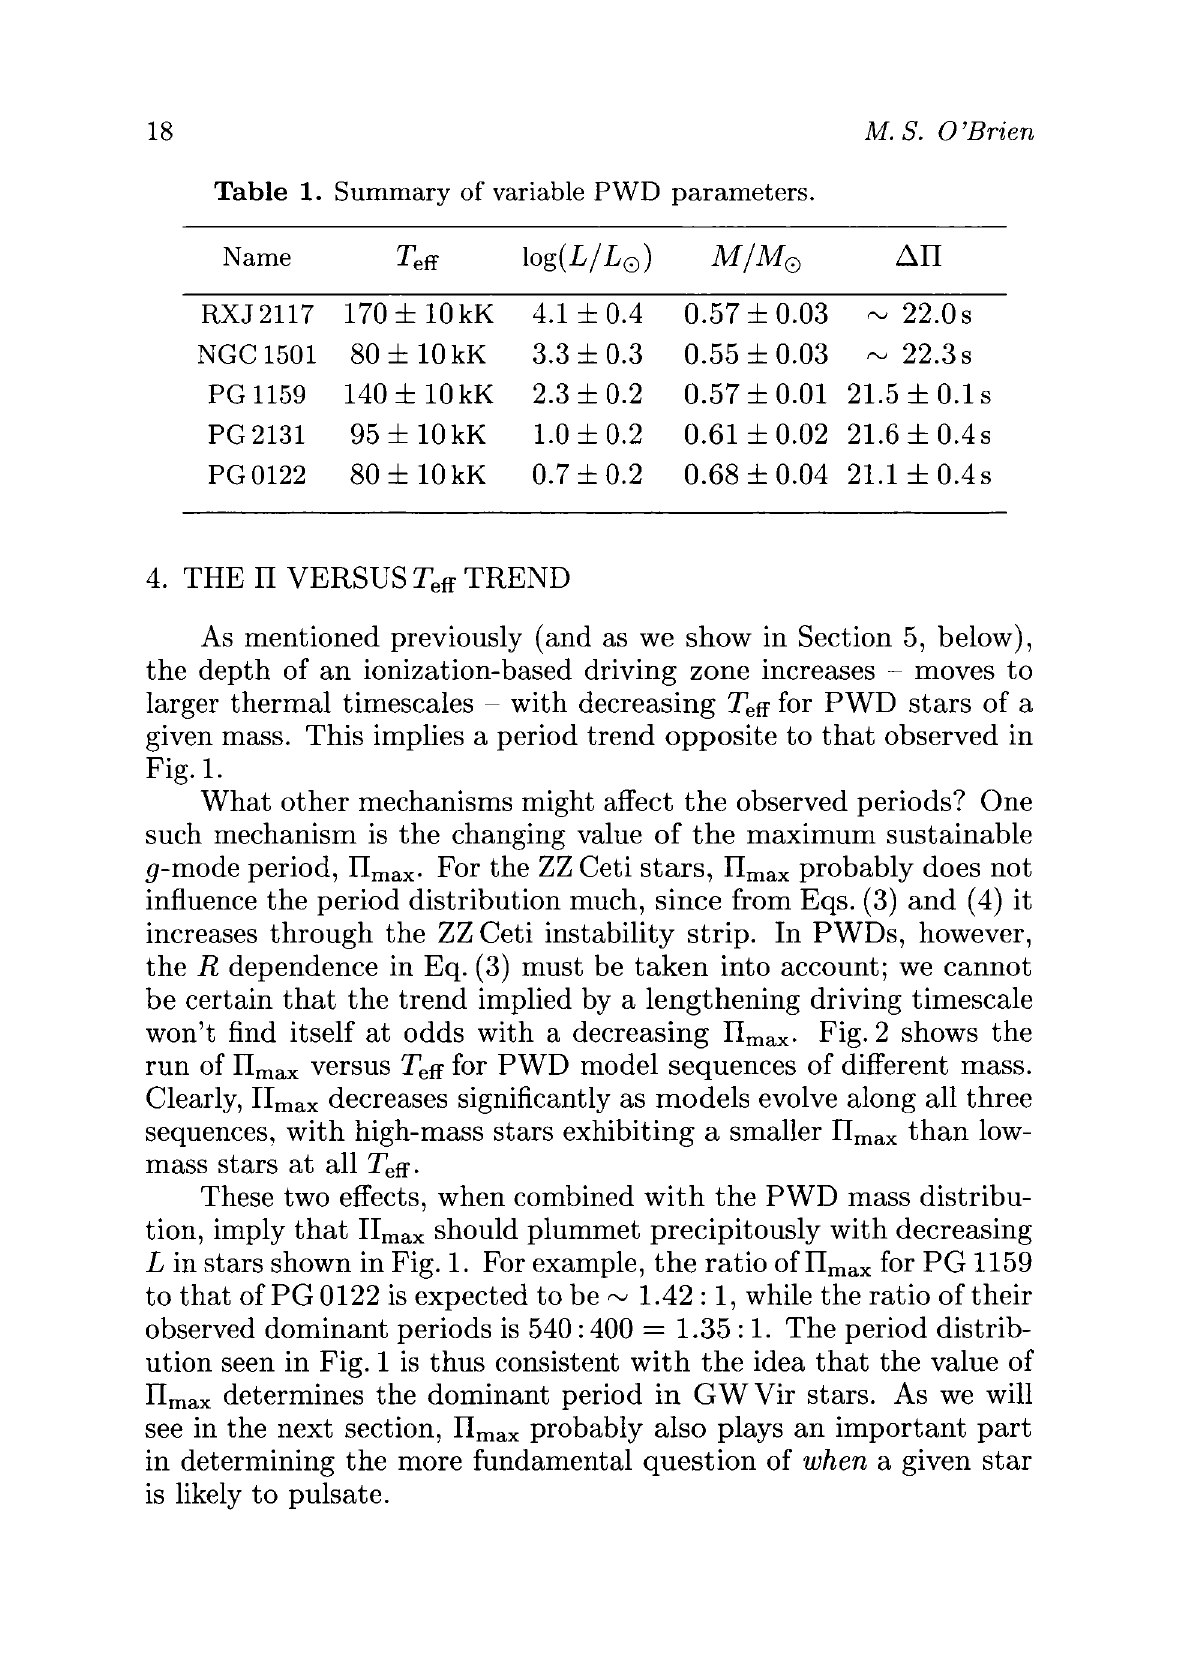
Table 1. Summary of variable PWD